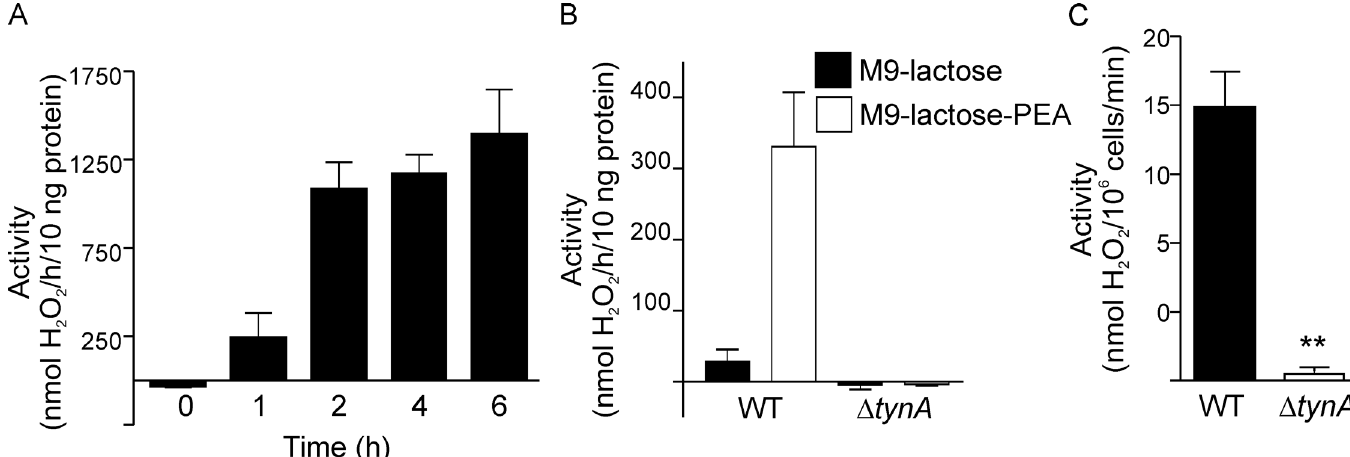
Fig 1. The time and medium dependence of ECAO expression and activity. ( A) The kinetics of ECAO induction in E . coli K-12 (wt) cultured in M9-lactose medium supplemented with 5 mM PEA (n = 4). The 0 h time point corresponds to the time when the cells were diluted into PEA-containing culture medium. (B) The activity of ECAO is induced in E . coli K-12 (wt), but not in our Δ tynA strain, by the presence of both lactose and PEA 6 h after diluting the bacterial cultures in M9-lactose-PEA media (n = 3). (C) The H 2 O 2 production of wt K-12 E . coli and Δ tynA bacteria in stationary phase in M9-lactose-PEA medium ( ** p < 0.01). The means ± SEMs are